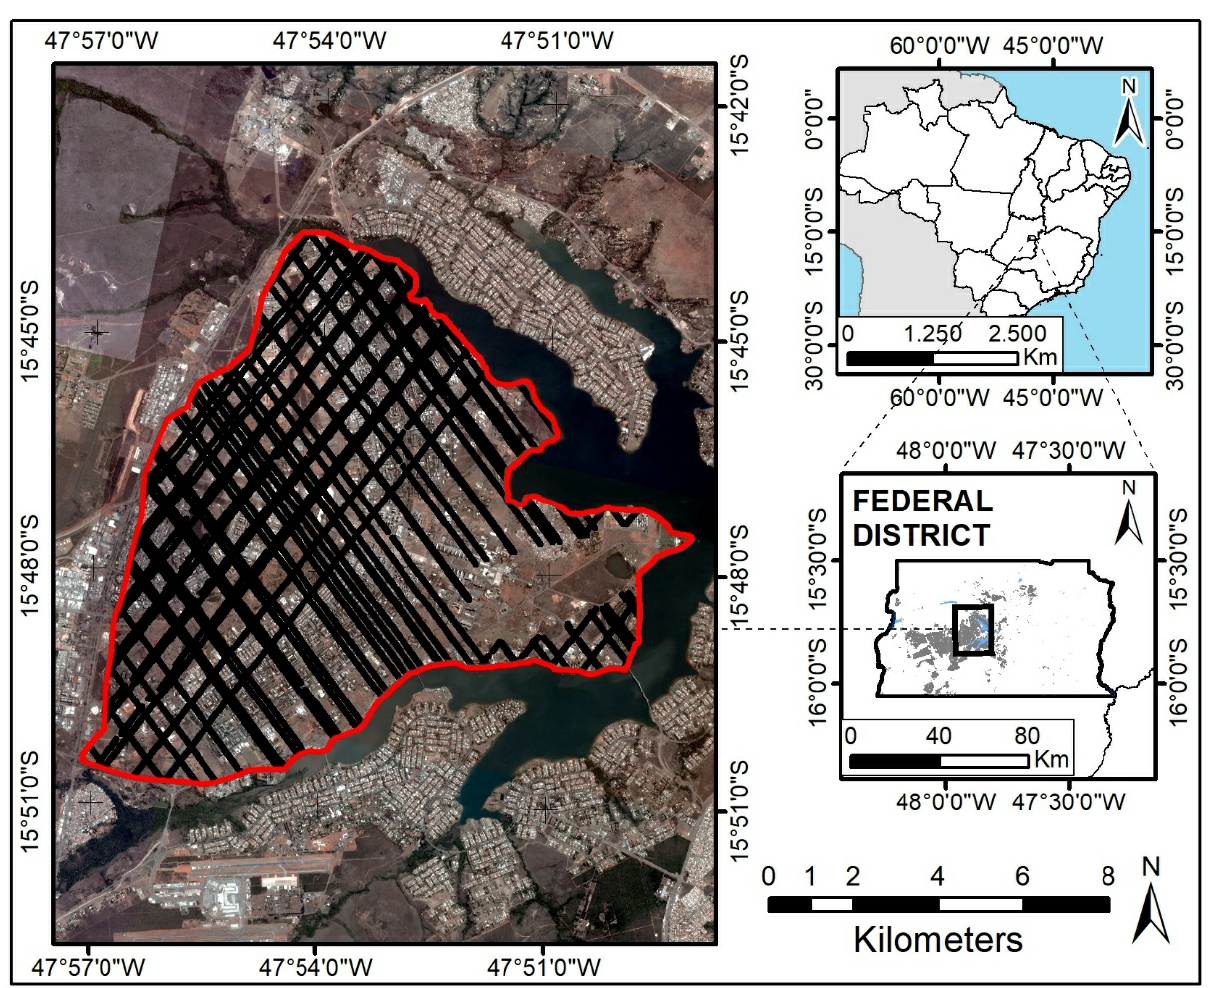
Figure 1. Study area located in Federal District. The red line represents the center of Brasília city and the black dots are GEDI data used in this study.